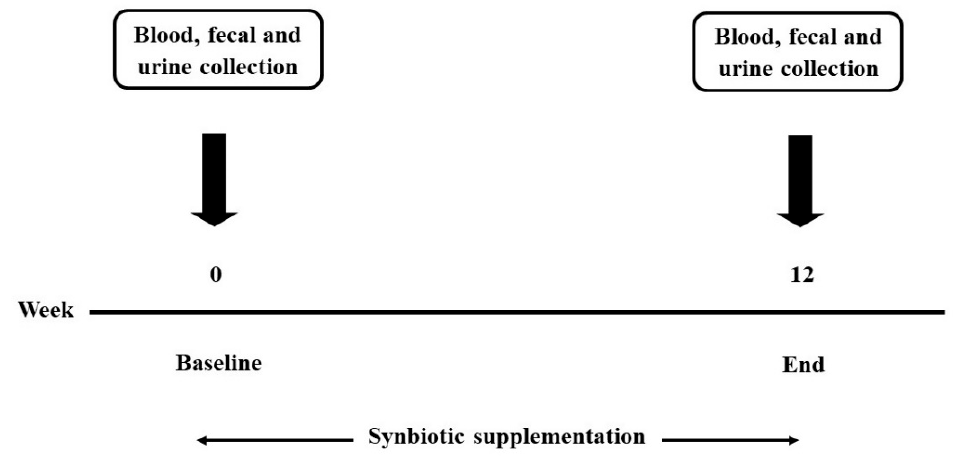
Figure 2. The timeline of this study.